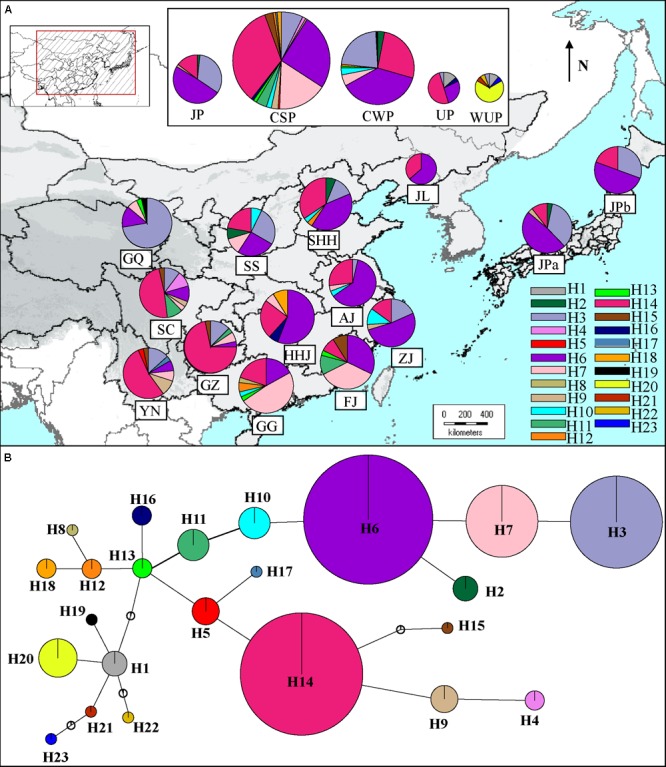
(A) Distribution of 23 haplotypes in geographic populations of cultivated Pyrus pyrifolia and Ussurian pears (UP and WUP). The 23 haplotypes, H1–23 are represented by different colors. The pie slices represent the proportion of different haplotypes in geographic population. The size of each circle approximately corresponds to the sample size (n) of the geographic population. (B) TCS-derived network based on combined cpDNA haplotypes. The circles represent different haplotypes. H1–23 represent haplotypes detected in Asian pear accessions. The small open circles represent missing haplotypes. The size of each circle is approximately proportional to the size of samples (n) harboring a certain haplotype, with the smallest circles representing n = 1 and the largest representing n = 134.